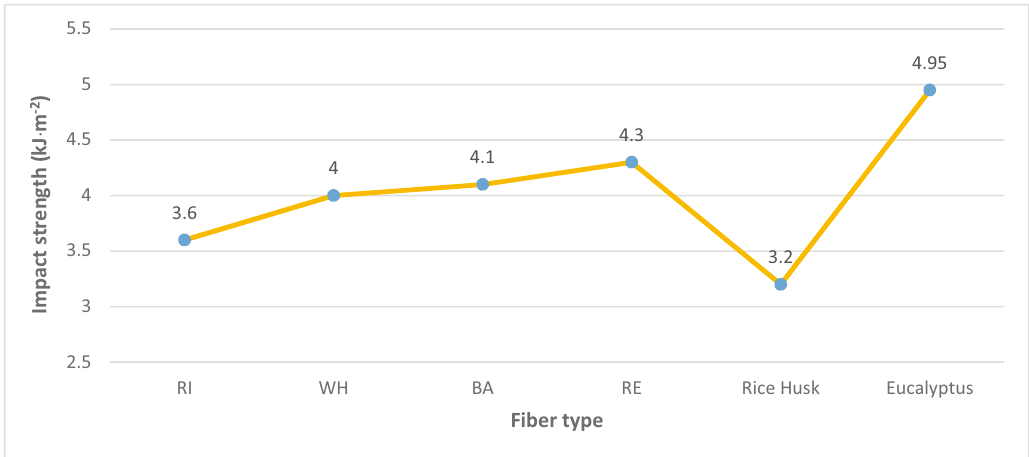
Figure 4: IS values of PVC composites at 50 wt% of di ff erent natural